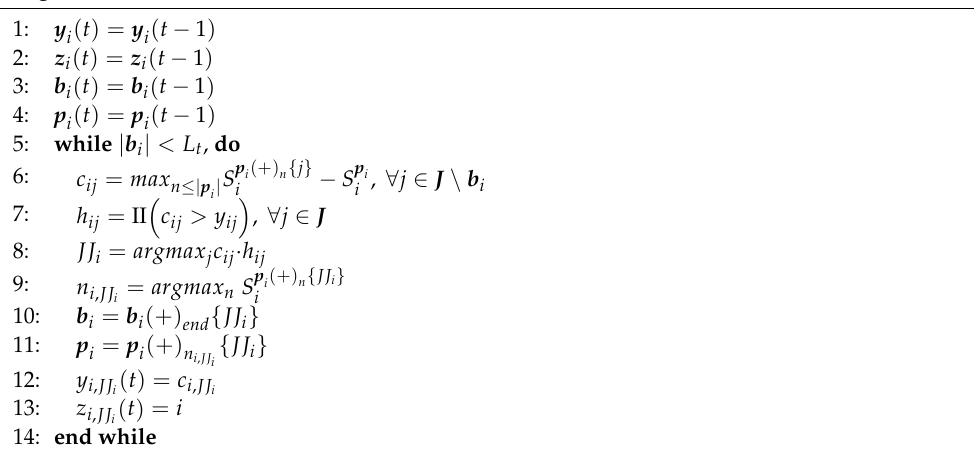
Algorithm 1 CBBA Phase 1: Bundle construction